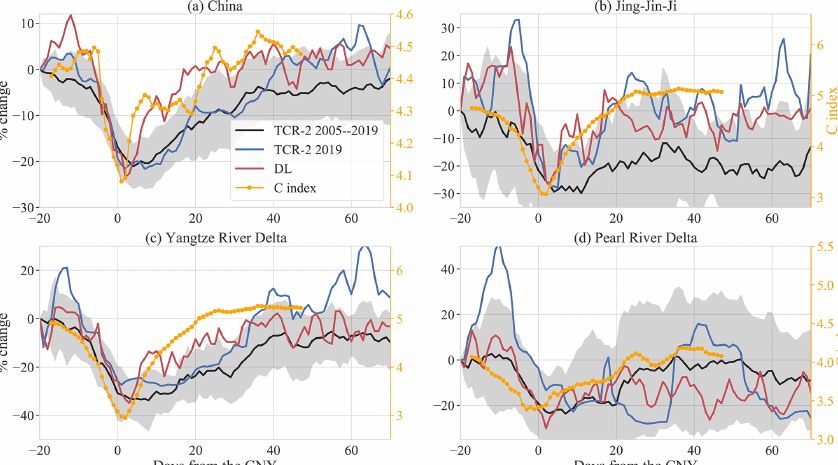
Figure 9. Time series of the percentage change in Chinese NO x emissions and the C-index Baidu mobile data as a function of days from the CNY. The differences are plotted relative to 20d before the 2019 CNY. Shown are time-series comparisons for (a) China, (b) the Jing-Jin-Ji region, (c) the Yangtze River Delta region, and (d) the Pearl River Delta region. The black line represents the TCR-2 mean for 2005–2019. The C-index is smoothed by a 7d window to remove weekly